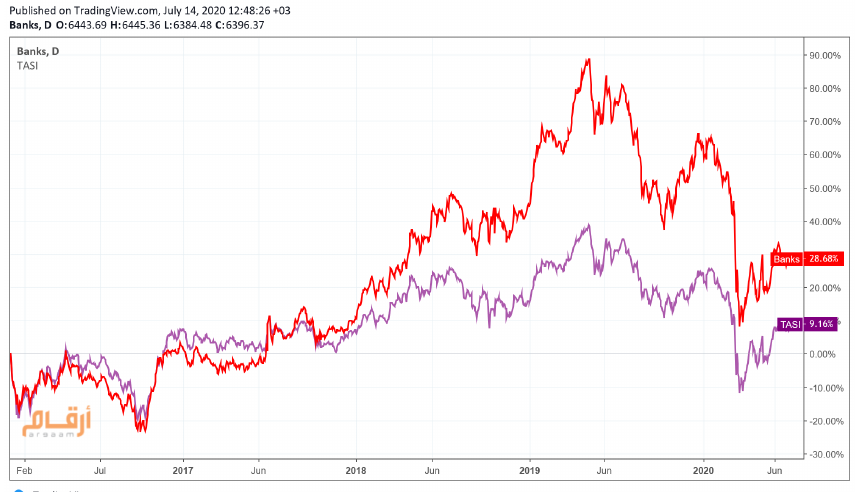
Figure 4. TASI vs. the Banking sector—in violet, the Tadawul index, in red, the banking stock index. Source Argaam